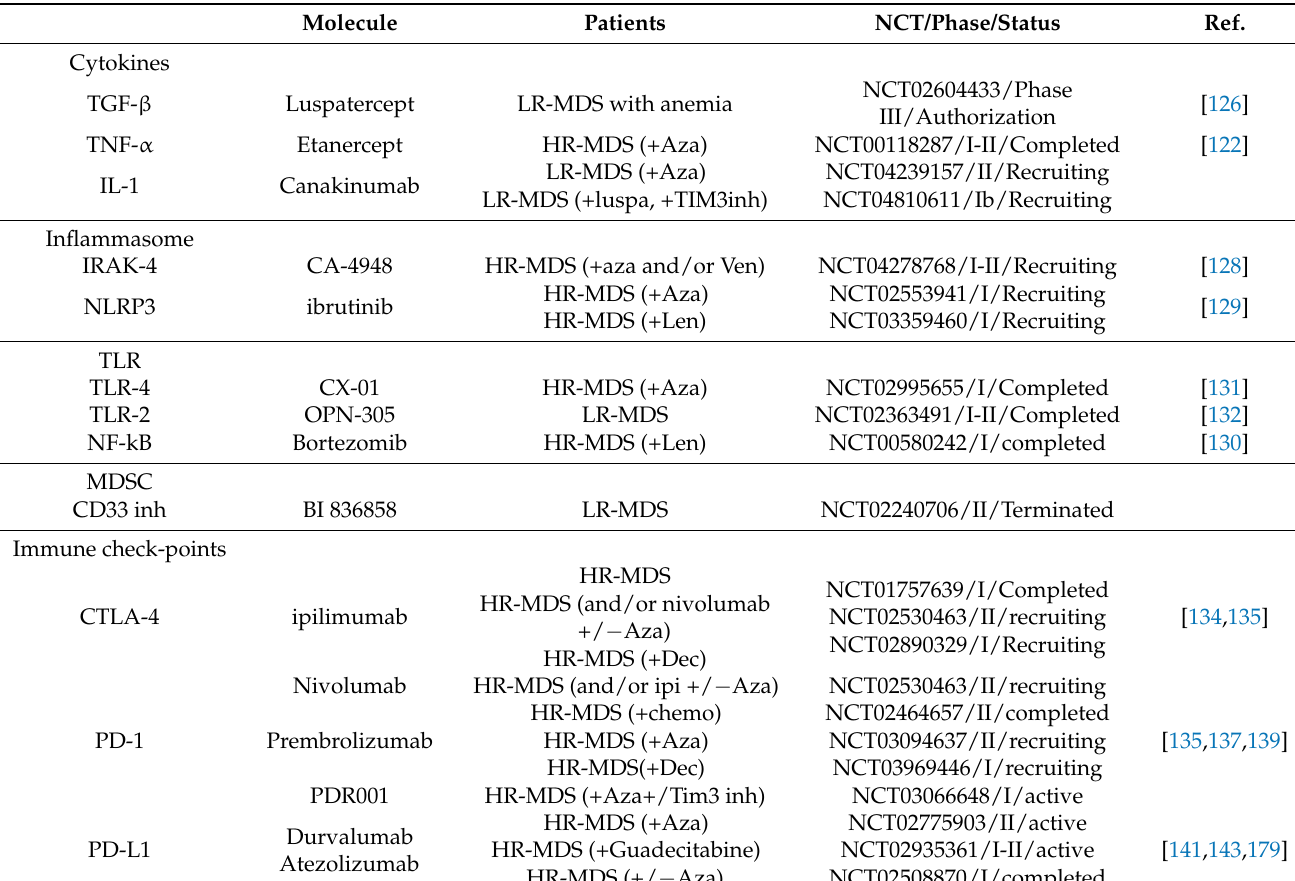
Table 1. Current and potential immune targets in MDS. Molecule Patients NCT/Phase/Status